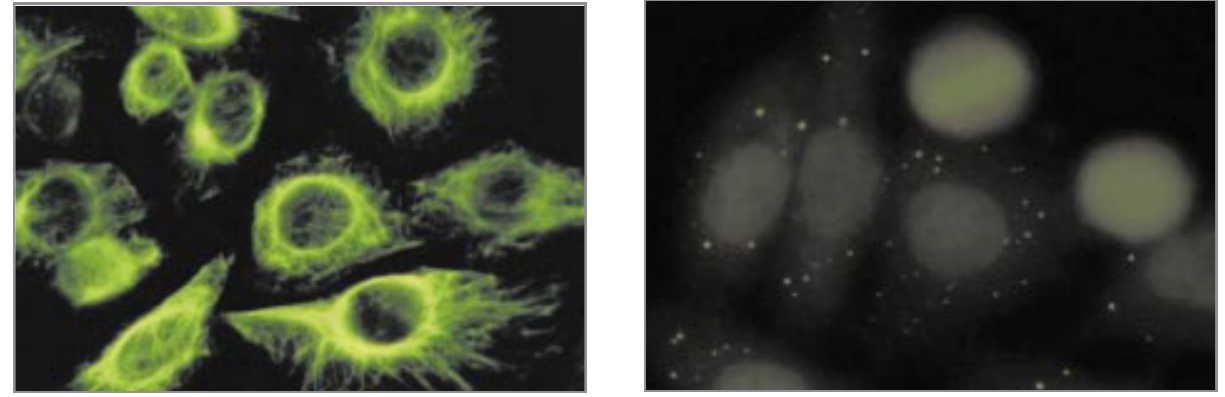
Figura 17 – Citoplasmático pontilhado com pontos